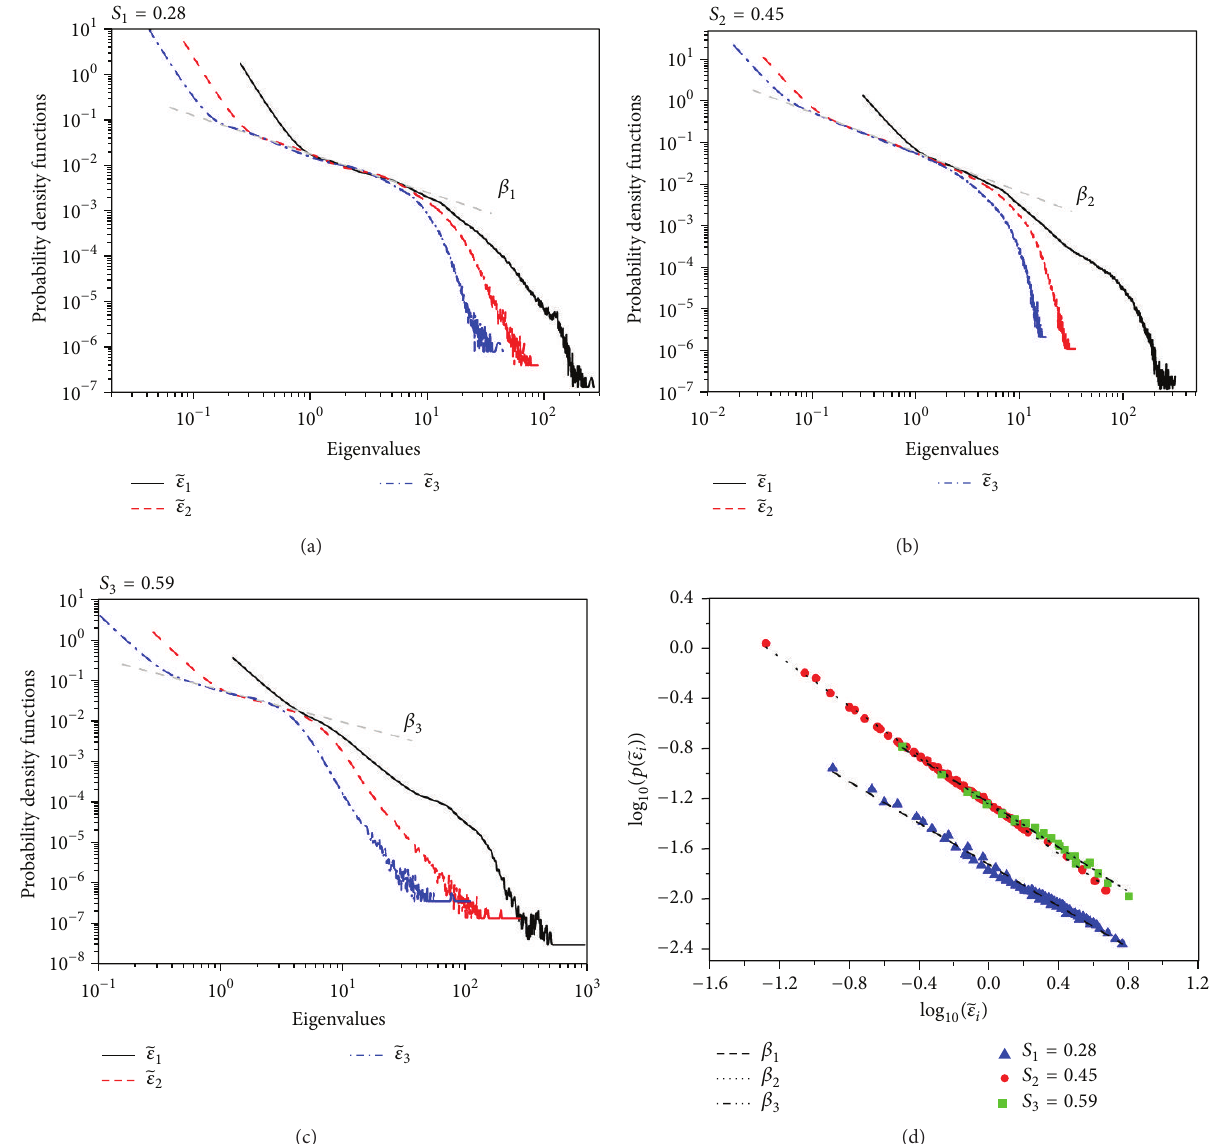
Figure 5: Probability density function 𝑝(𝜀) for 𝑆 1 = 0.28 (a), 𝑆 2 = 0.45 (b), 𝑆 3 = 0.59 (c), and the linear subrange of them (d).